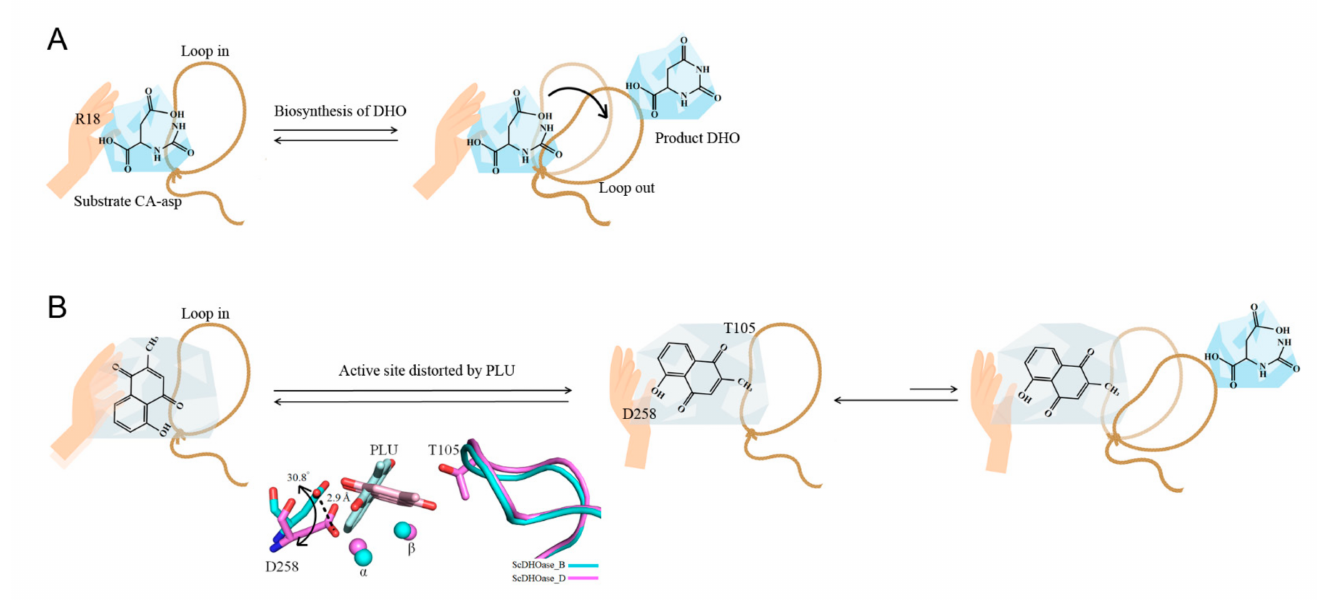
Figure 10. Proposed inhibition model. ( A ) The dynamic loop for the substrate entrance of DHOase. The structure of EcDHOase reveals a flexible loop that extends toward the active site when CA-asp is bound (the loop-in mode) or moves away from the active site, facilitating the release of the product DHO (the loop-out mode). The flexible loop in EcDHOase is crucial for stabilizing the transition state and catalysis, supporting that the movement of this loop is a part of the catalytic cycle. ( B ) The active site distorted by PLU. Analysis of 5-FU- and 5-AU-complexed structures of ScDHOase indicated loop-in binding mode; however, they were not